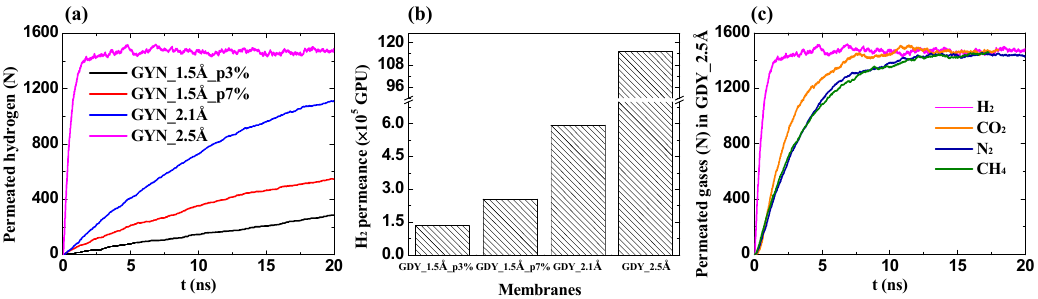
Figure 3. Pure gas permeation. ( a ) The time evolution of permeated H 2 molecules; ( b ) The permeance of H 2 through different GDYs; ( c ) The permeation of four gases in GDY_2.5Å.